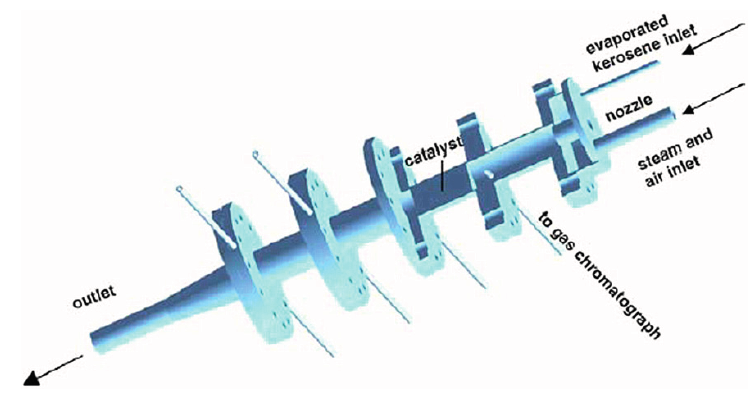
Figure 15. Schematic of reactor [31].